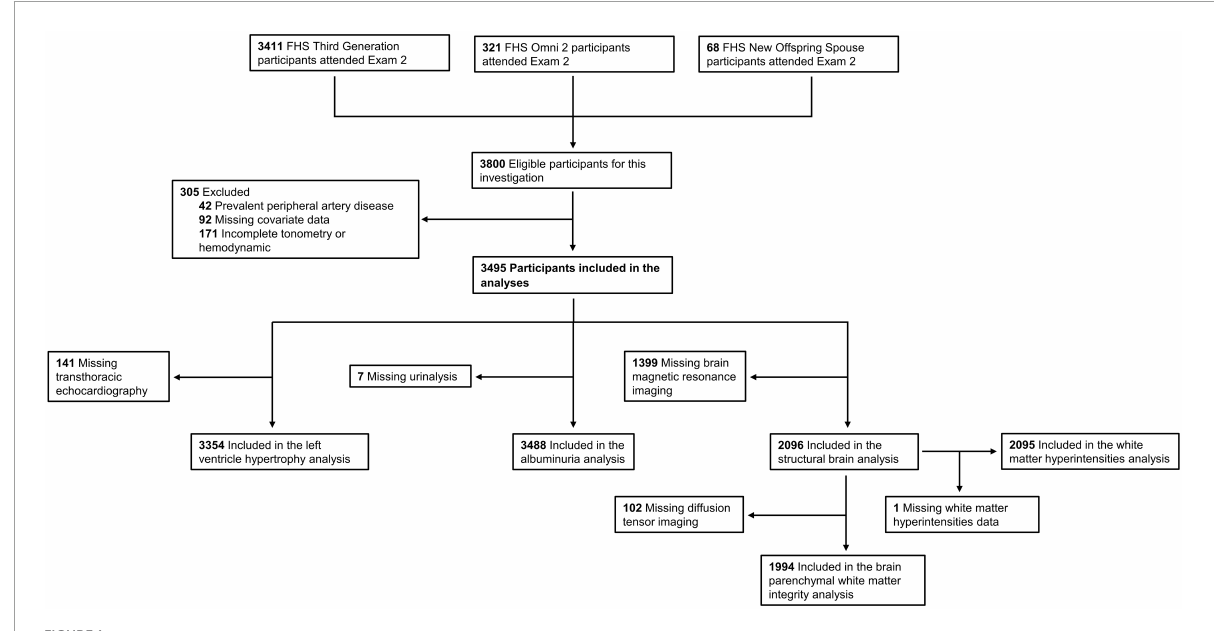
FIGURE1 Flow diagram of the analysis sample